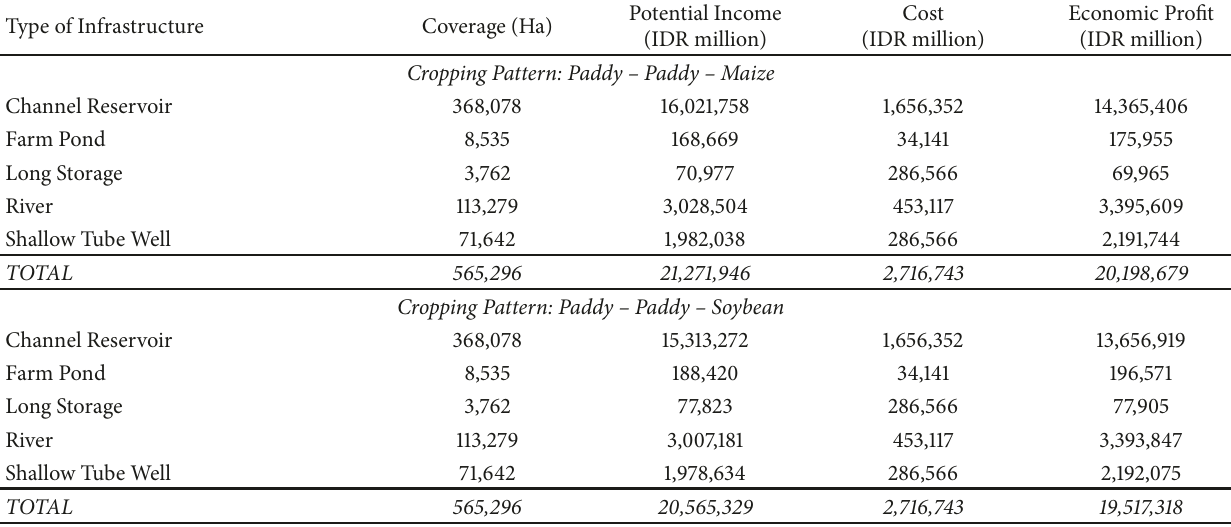
Table 4: Potential economic return from investment on water harvesting infrastructure.